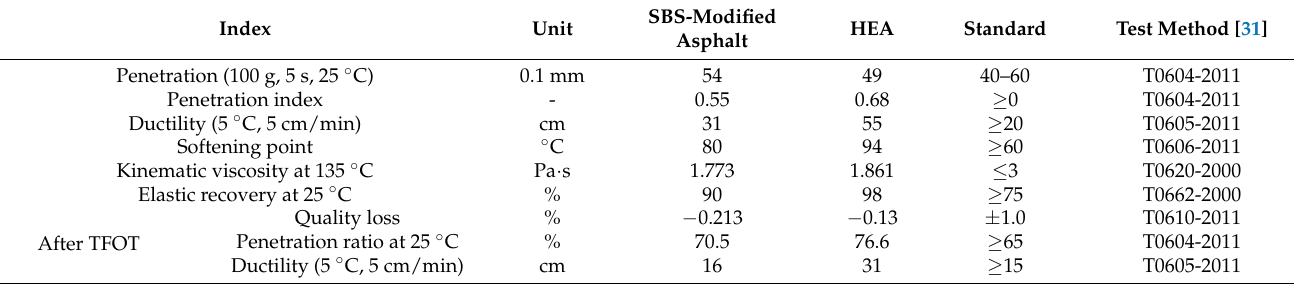
Table 1. Basic indicators of the two